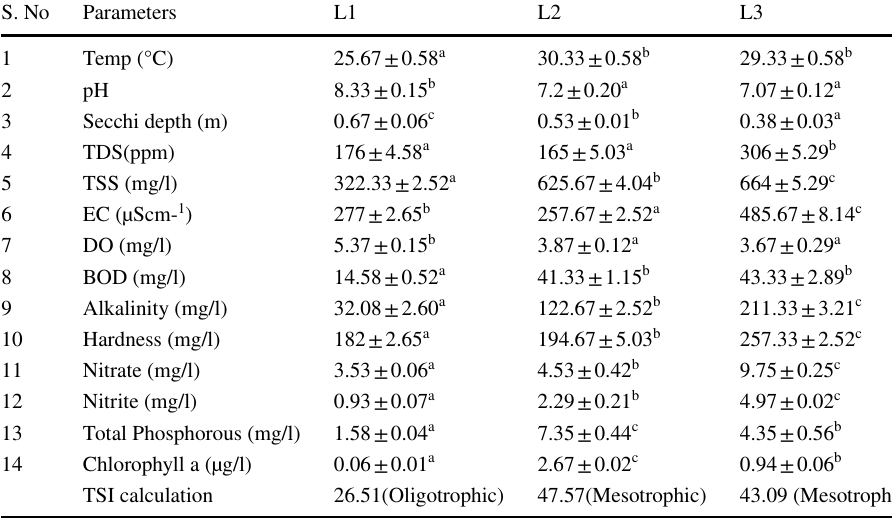
trophic state of lakes during post-monsoon